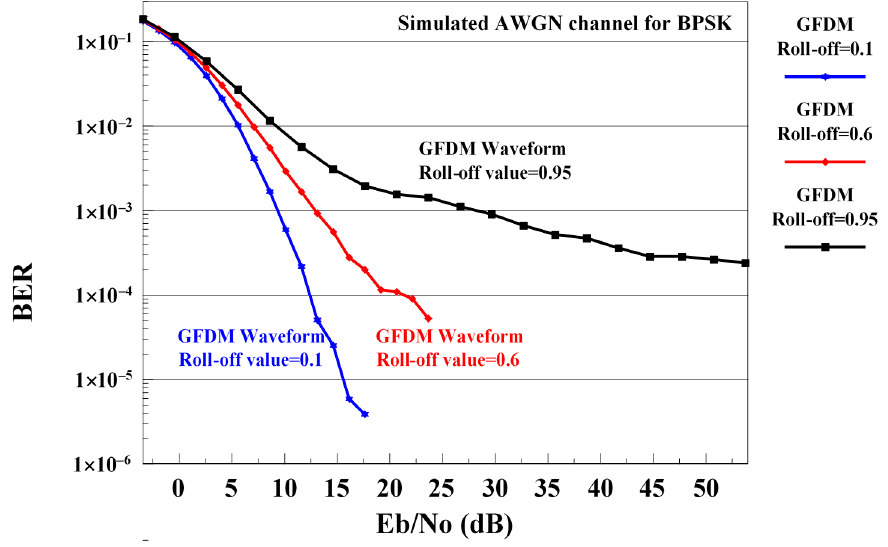
Figure 4. The effects of different roll-off values on the BER performance of GFDM waveform in AWGN AWGN channel.